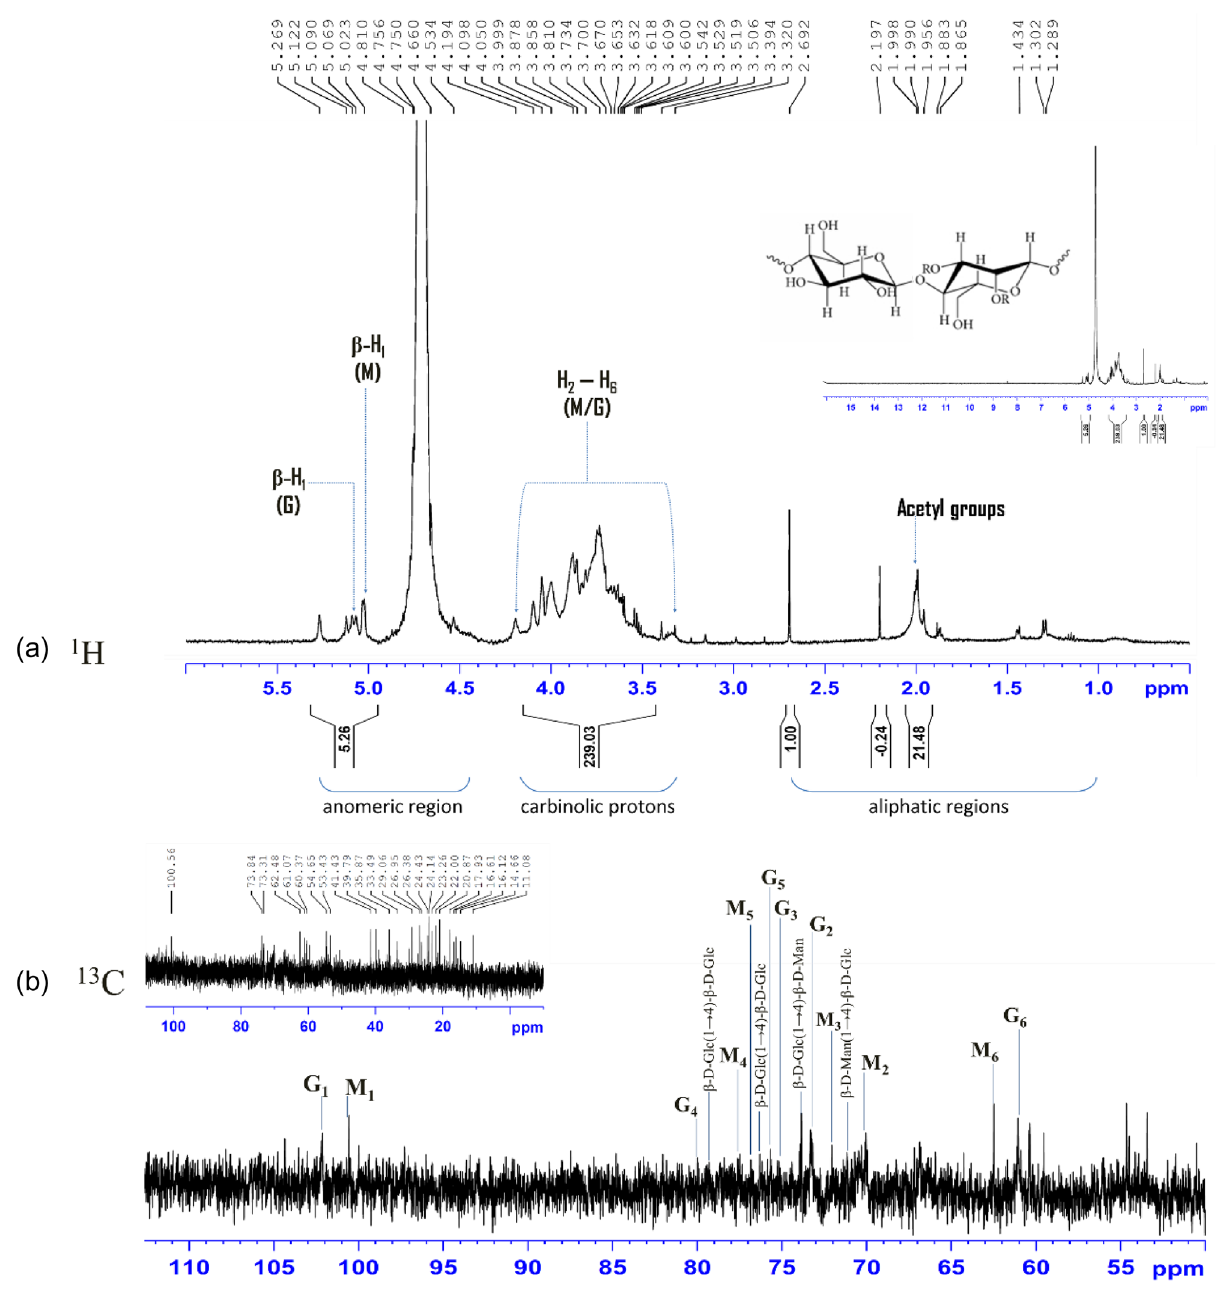
Figure 6. 500 MHz proton ( a ), and carbon ( b ) NMR spectra of purified